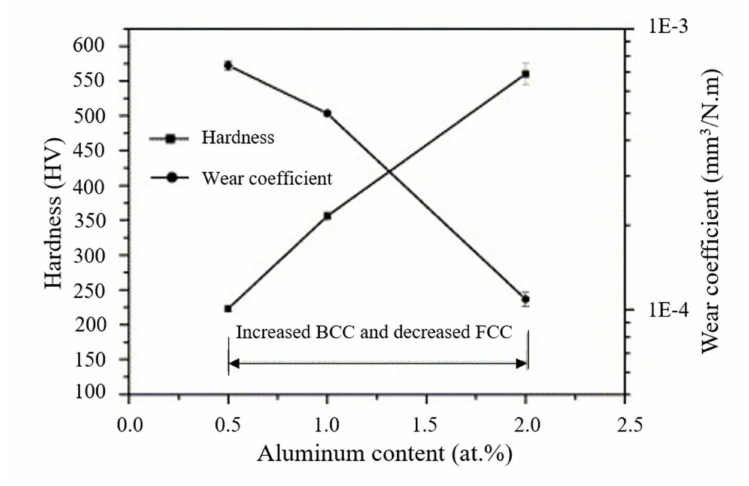
Figure 10. Hardness and wear rate variation over Al content in the AlCoCrCuFeNi HEAs [51].